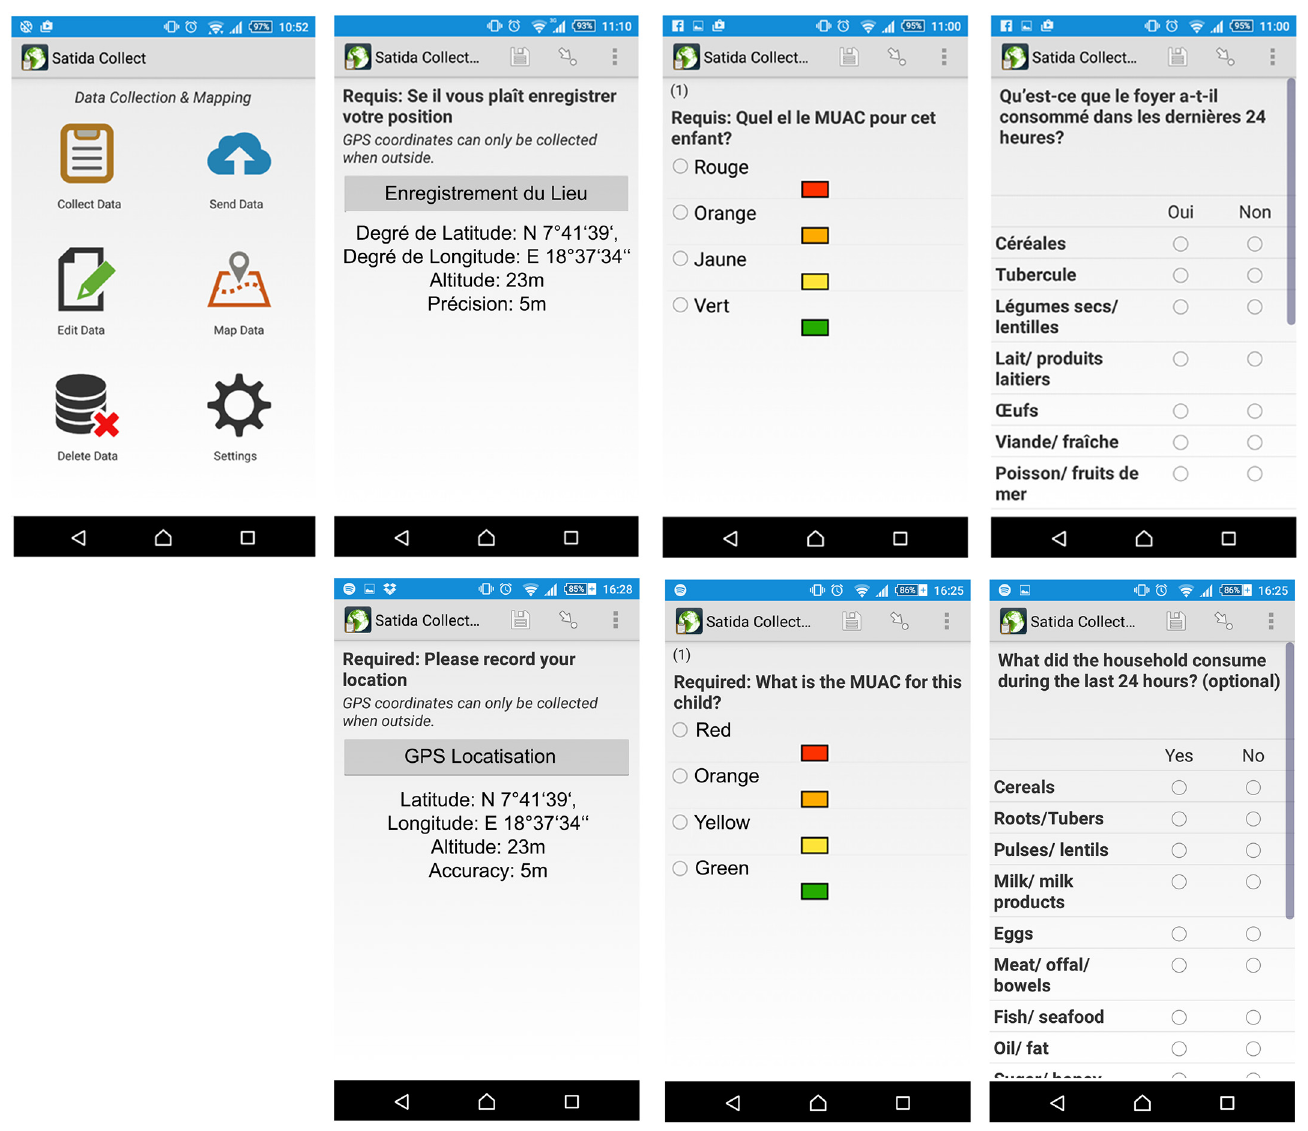
Fig 2. Selected Screenshots of SATIDA COLLECT (start screen, GPS localisation, MUAC measurement, food consumed during last 24 hours) in French and English.